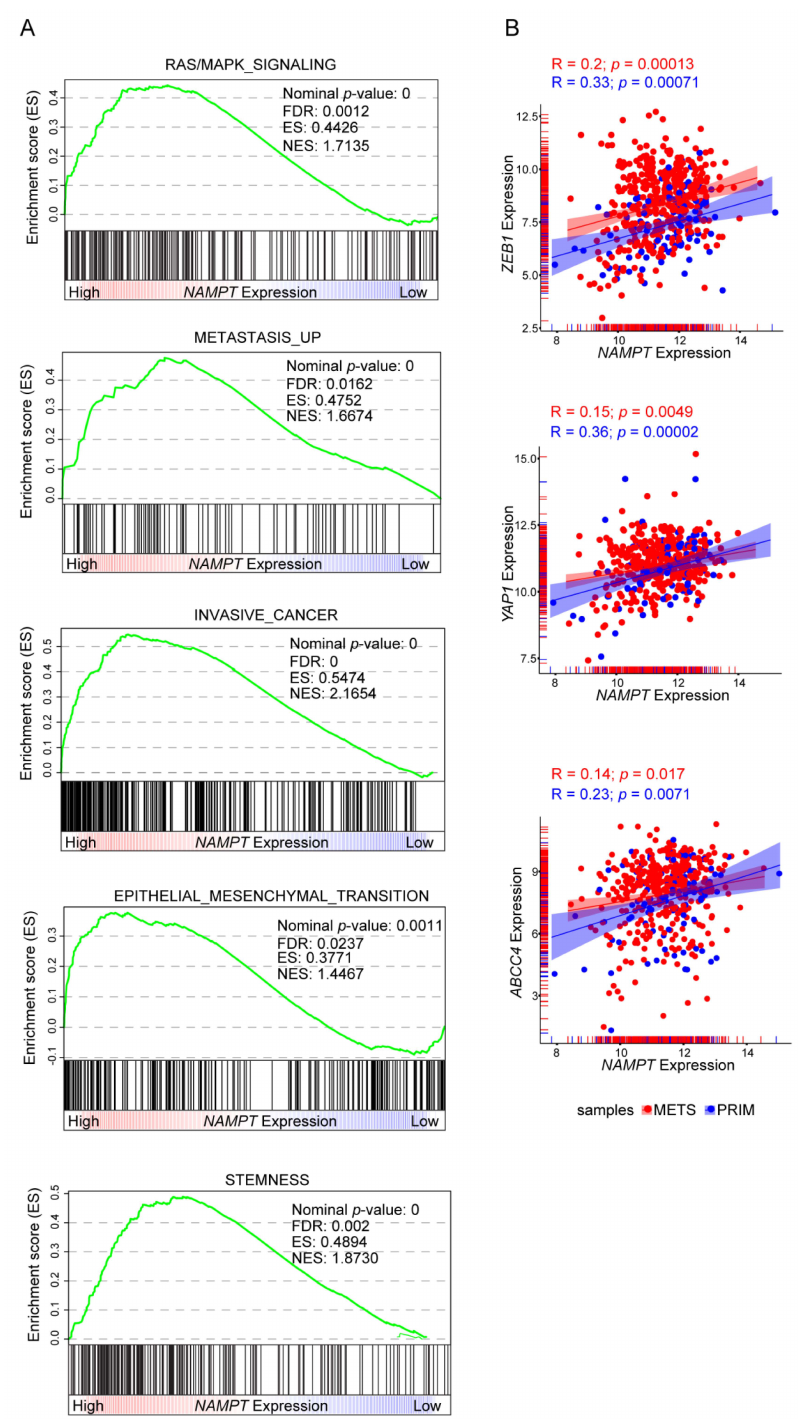
Figure 5. Positive correlations between NAMPT expression and cancer aggressive features in gene set enrichment analysis of TCGA melanoma patients cohort. ( A ) GSEA plots of di ff erentially expressed genes, belonging to the indicated categories, between high and low NAMPT expressing Skin Cutaneous Melanoma (SKCM) samples of the TCGA cohort. All the represented gene sets positively correlates with NAMPT expression at a false discovery rate (FDR < 0.05). Enrichment score (ES), normalized enrichment score (NES). ( B ) Scatter plot correlating NAMPT expression and ZEB1 , YAP1 , and ABCC4 respectively. Each dot represents a sample of the TCGA SKCM cohort, colored in red if metastasis (METS) derived and in blue if primary (PRIM) tumor-derived. Pearson correlation (R) and p -value are shown. The expression of all three genes positively correlates with NAMPT